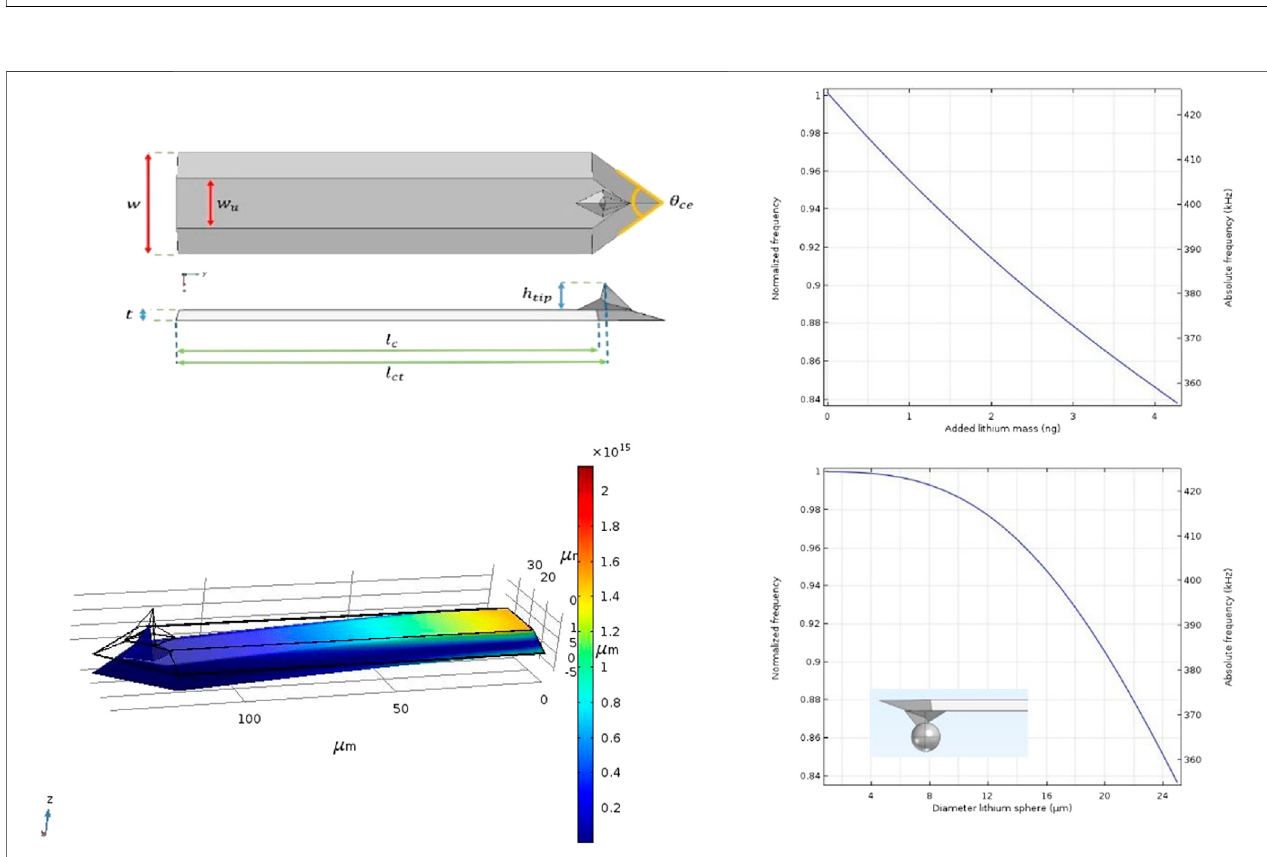
Frontiers in Chemistry |